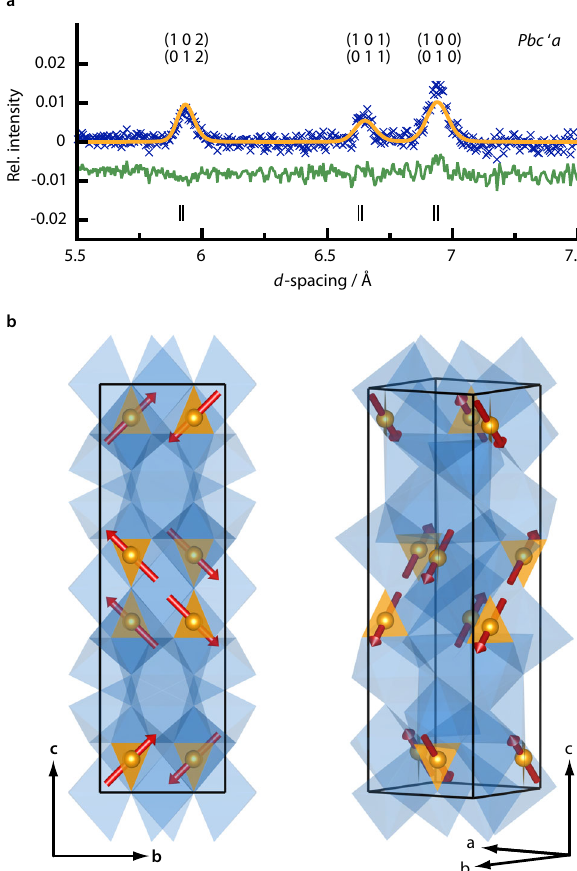
Fig. 4 Magnetic structure of Ca 4 FeN 4 . a Magnetic structure re fi nement carried out on the difference of data collected at 1.5 and 50 K of detector bank 1. Blue crosses are datapoints, orange is the fi t of the magnetic structure, green is the difference curve. Positions of re fl ections are marked by vertical drop lines, their hkl indices displayed above the re fl ection. b Magnetic structure shown in two different directions. [FeN 3 ] 5 − polygons in orange, CaN 6 polyhedra in